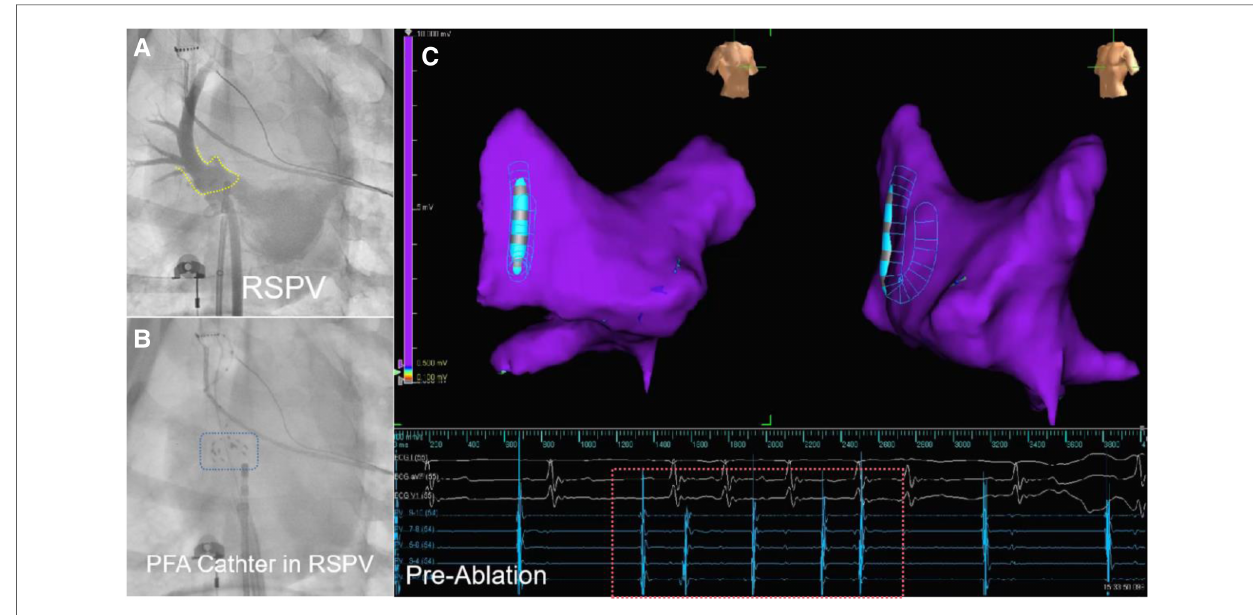
FIGURE 2 The DSA image and electroanatomical mapping (image from dog B2) is presented in three parts. Part ( A ) shows a DSA of the PV with the yellow dashed frame marking the PV ostium. Part ( B ) shows the PFA ablation catheter in preparation for discharge at the right superior PV antrum, with the blue dashed box showing the developing image of PFA ablation catheter under DSA. Part ( C ) shows that the left atrial electroanatomical modeling before ablation reveals an unisolated state of the PV. The red dashed box portion represents the pre-ablation PV electrogram, indicating that PV signals can be